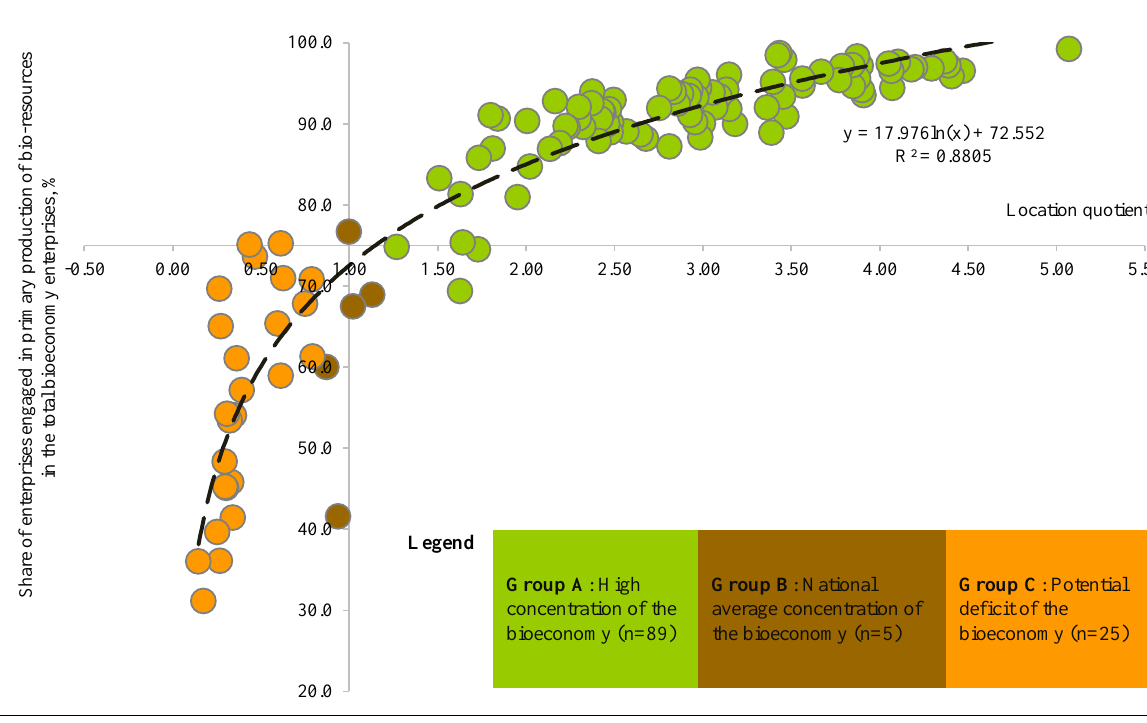
Figure 3. Scatter diagram of location quotients for the bioeconomy (coefficient) and the shares of enterprises engaged in primary production of bioresources in the total bioeconomy enterprises (%) in 2019; the regression curve and the equation The analysis of the locations of administrative territories of Latvia in connection with location quotients for the bioeconomy (coefficient) and the shares of enterprises engaged in primary production of bioresources in the total